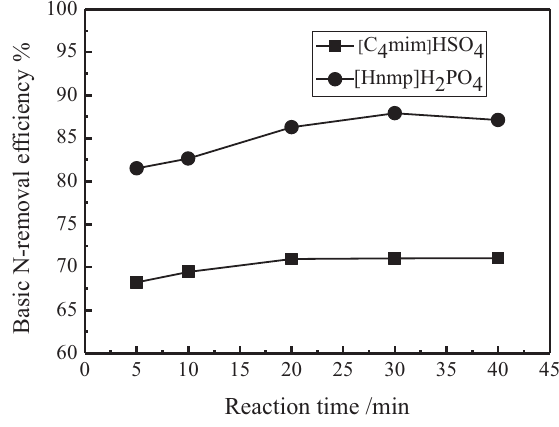
Fig. 4 – Basic N-removal effect of two ionic liquids at differ- Fig. 4 ent reaction times. Reaction conditions: IL/oil mass ratio = 1:7, temperature = 30 °C, settling time =2